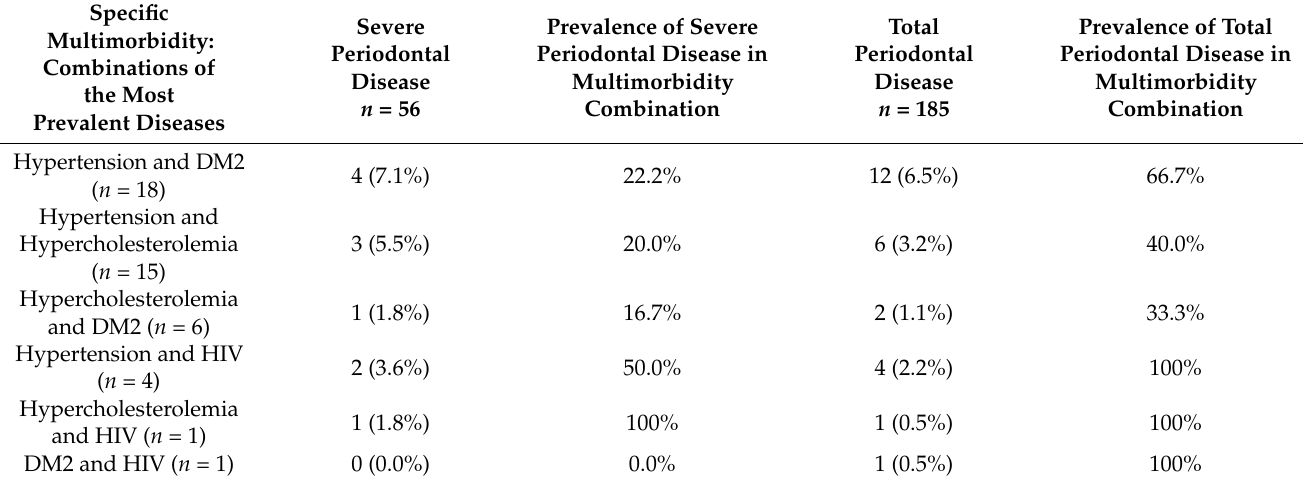
Table 6. Prevalence of multimorbidity combinations for the most prevalent